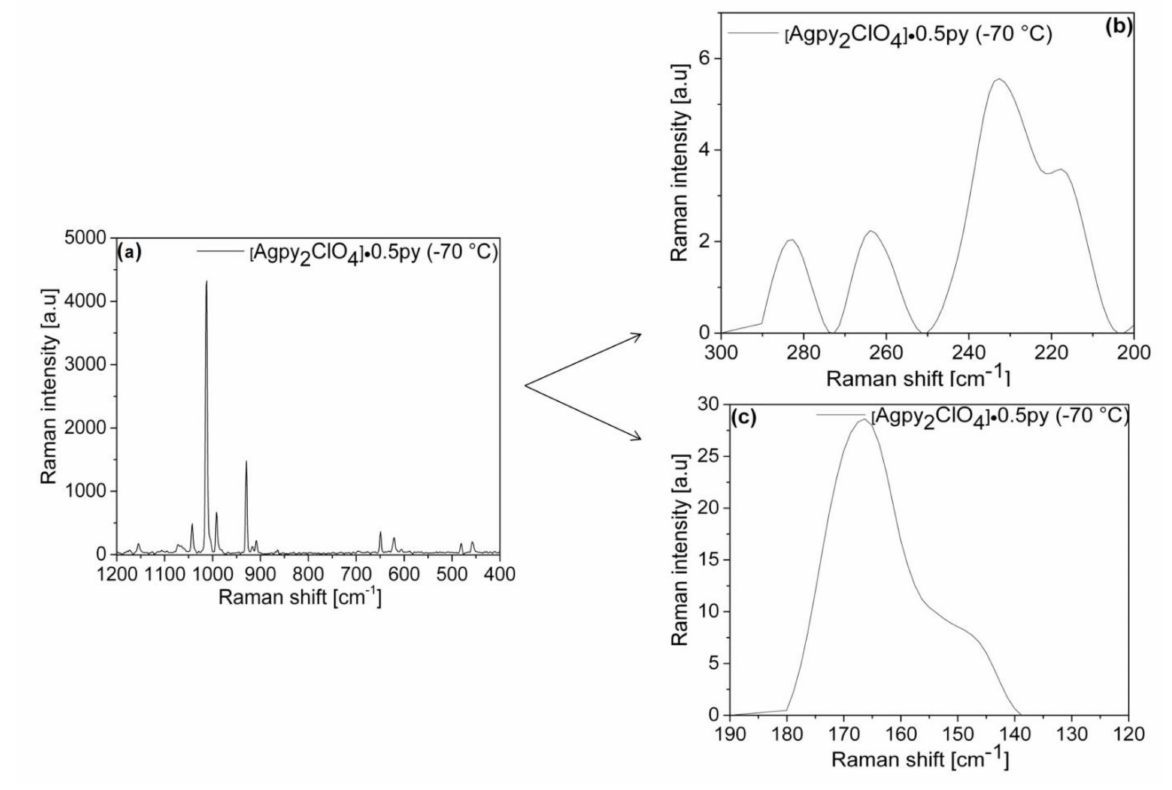
Figure 10. Raman spectra of compound 1 at 203 K between 1200 and 400 cm − 1 ( a ), 300 and 200 cm − 1 ( b ), and 190 and 130 cm − 1 ( c